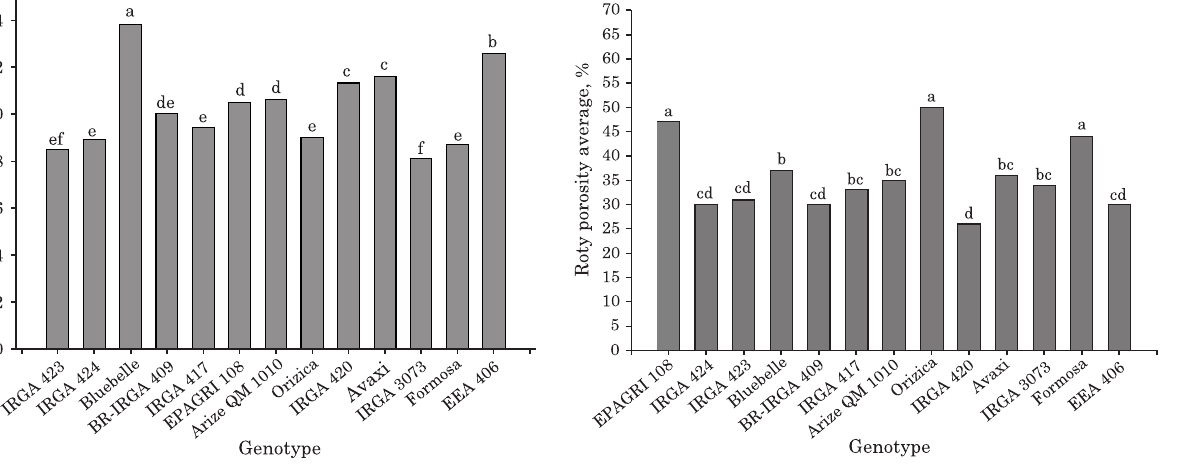
Figure 2. Average diameter in three segments of adventitious roots of rice genotypes produced under conditions of hypoxia. Lowercase letters compare genotypes by the LSD test (p<0.05).